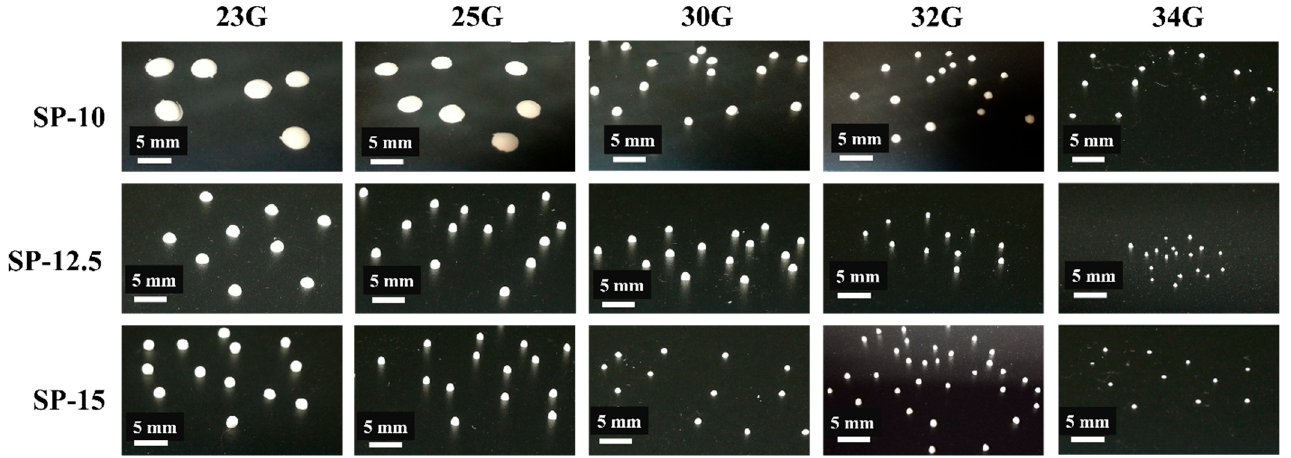
Figure 2. Pictures of the 3D-printed beads produced using starch concentrations of 10, 12.5, and 15% ( w / w ) and nozzles with different diameters (23, 25, 30, 32, and 34G). The bead size of starch beads significantly ( p < 0.05) decreased with decreasing the nozzle diameter and increasing the starch concentration. Regarding the size and sphericity of the starch beads, the best results were obtained with a 15% starch concentration and nozzle 34G (Figure 2). As depicted in Table 2, the sphericity for SP-15 is close to 1, indicating that the beads are almost spheres. Nevertheless, the sphericity of SP-12.5 and especially SP-10 significantly deviated from 1. The results confirmed that by increasing the starch concentra- tion, the resulting bio-ink enabled better retention of the spherical shape. However, the 3D printability could be maintained as long as the starch concentration, as the dominant factor,